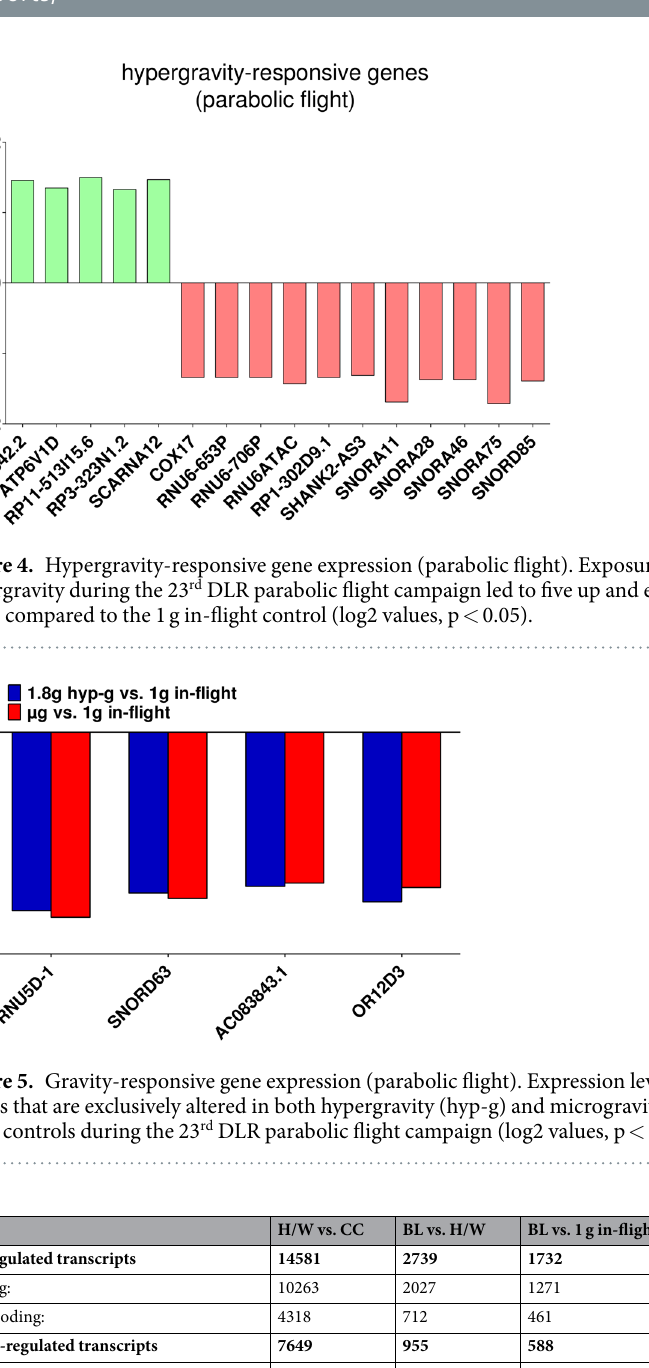
Table 5. Differentially expressed transcripts in T cells during the TEXUS-51 mission. Number of significantly differentially expressed transcripts that were up or down-regulated in the respective comparison. CC: